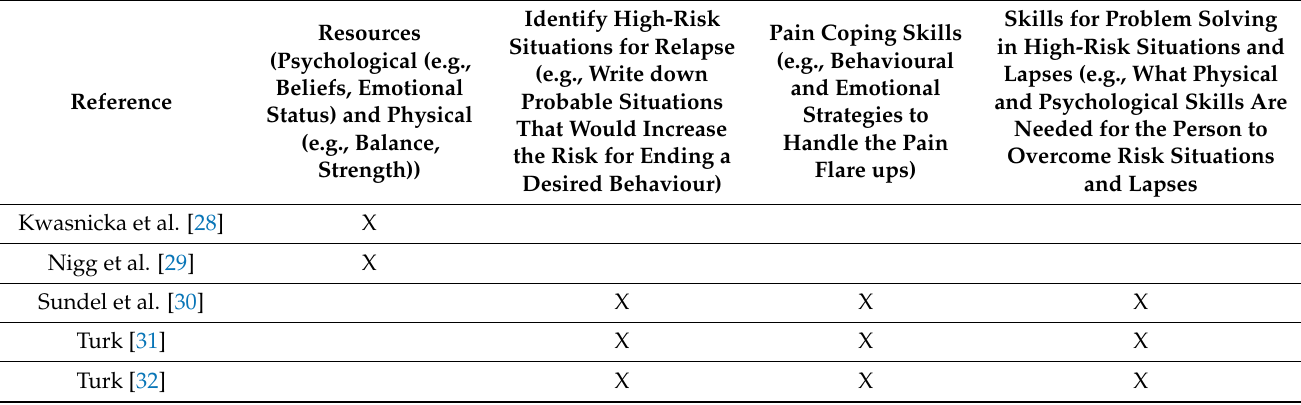
Table 6. Maintenance of behavioural change components categorized according to the behavioural wheel presented by Michie et al. [42] regarding capability, motivation and opportunity. Capability: Capability consists of a person’s physical and psychological knowledge and skills needed to engage in a target behaviour/activity.